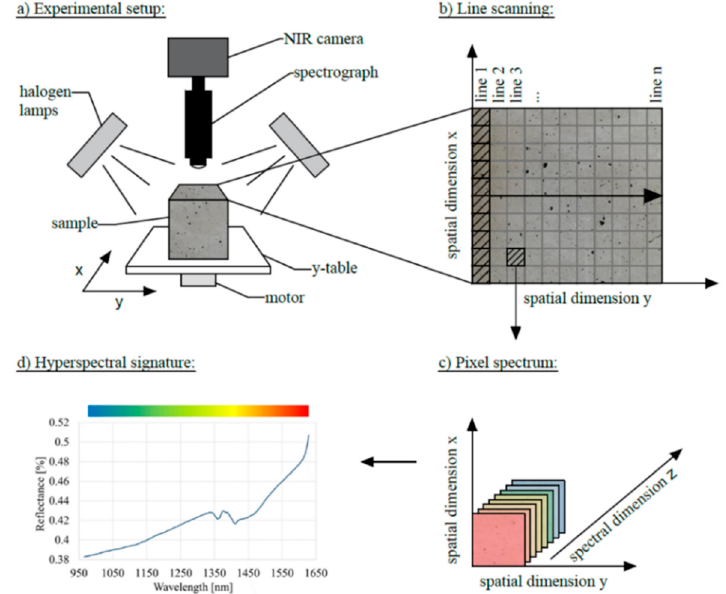
Figure 1. Hyperspectral imaging setup and data composition.